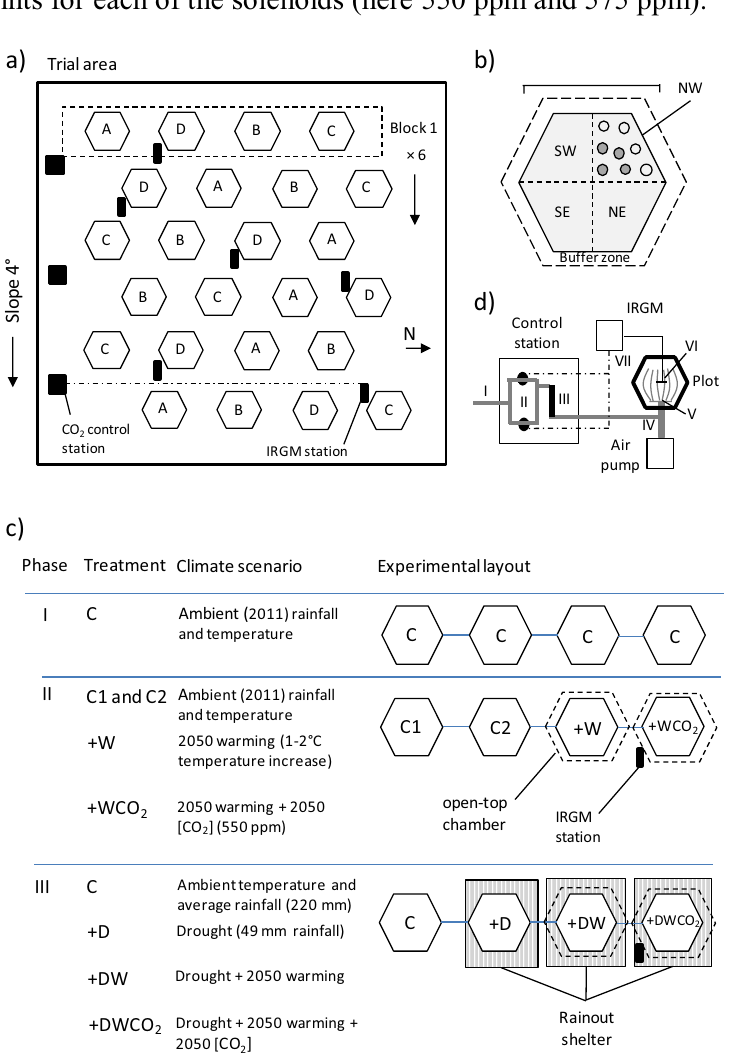
Figure 3. Design and layout of the field experiment. ( a ) Layout of the study site. Each block (n = 6 total) contained four plots, each of which was assigned to one of four climate ; labeled A (cid:177) D) as treatments in Phase III of the experiment (C, +D, +DW and +DWCO 2 defined in (c). ( b ) Layout of a study plot (n = 24 total). Hexagon-shaped plots (2.2 m 2 ) were divided into four equal-sized quadrants (NW, NE, SE and SW), each of which contained eight plants (cid:178) four inside (grey circles) and four edge (white circles). ( c ) Treatment structure, experimental layout and simulated climate scenarios during Phases I, II and III of the experiment. Note that the four climate treatments were randomly allocated enrichment system. A line of pure to plots within each block. ( d ) Basic design of the CO 2 CO (I) is supplied to each CO -enriched chamber via a CO control station [shown in (a)], 2 2 2 where it is split into two lines, the flow of each being controlled by a solenoid valve (II). lines then merge, pass through a flow meter (III), and enter a main air line (IV) Both CO 2 then mix in a mixing which is supplied by a 60 L min (cid:237) 1 air pump. The air and pure CO 2 injection tubes. The CO manifold (V) and enter the plot via a series of porous CO 2 2 concentration is sampled by an infra-red gas monitor (IRGM) via a sampling manifold placed in the center of the plot (VI); the IRGM controls the solenoids via relays (VII) with different set-points for each of the solenoids (here 550 ppm and 575 ppm).